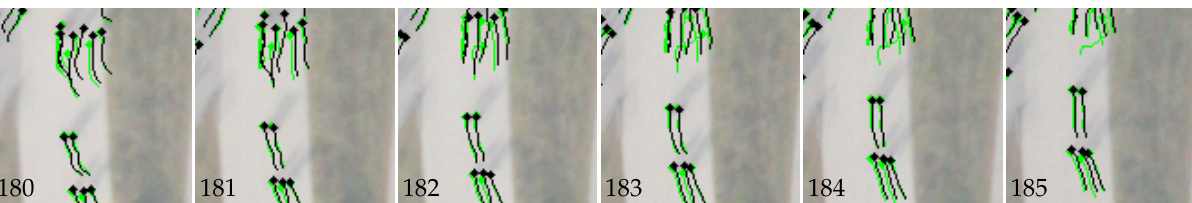
Figure 9. A success case by Stacked-DCFNet on the sequence “AA_Crossing_02”. The tracking results and ground truth are depicted in green and black, respectively.